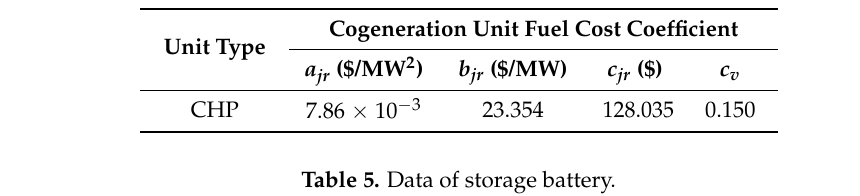
Table 4. Combined heat and power unit parameters.